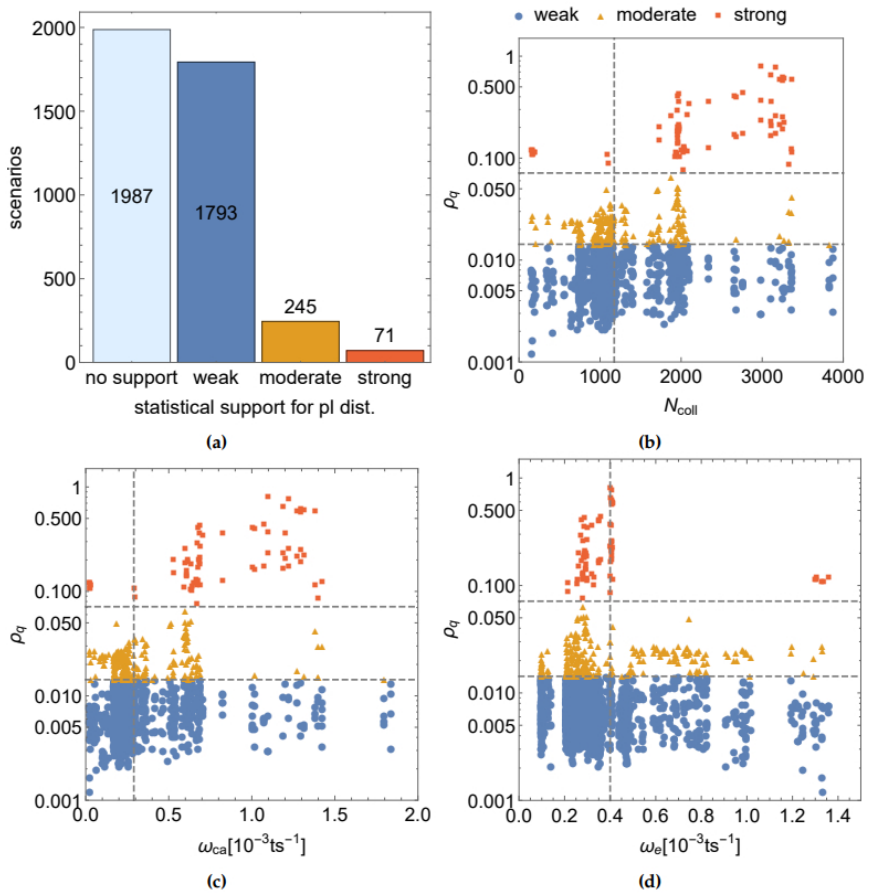
Figure 2. ( a ) Feature data sets obtained from simulations, sorted by the type of statistical support for a corresponding power law fit. The classifications follow Table 3. ( b – d ) Log-linear scatter plots relating the power law fit quality ratio ρ q to the swarm performance in terms of N coll , ω ca and ω e , respectively. The vertical dashed lines indicate the mean performance values while the horizontal dashed lines separate the quality categorizations taken from Table